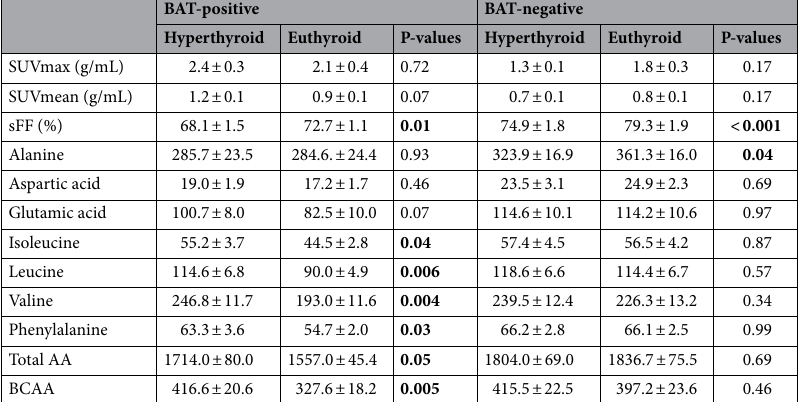
Table 4. Comparison amino acids profile between hyperthyroid state and euthyroid state in BAT-positive and BAT-negative participants. N = 21. BAT-positive n = 8, BAT-negative n = 13. Data presented as mean ± SEM. P values represents Independent Sample’s t -test between BAT-positive and BAT-negative subjects. Statistically significant values are shown in bold. SUVmax standardized uptake value maximum, SUVmean standardized uptake mean value, sFF supraclavicular fat fraction, AA amino acids, BCAA branched-chain amino acids (isoleucine, leucine and